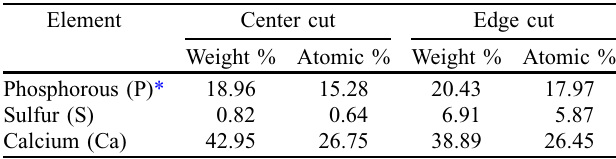
Table 1. X-Ray data for the middle and edge scans from the gallium cut proboscis hooks of specimens of Rhadinorhynchus oligospino- sus showing c enter and edge of the mid cut.